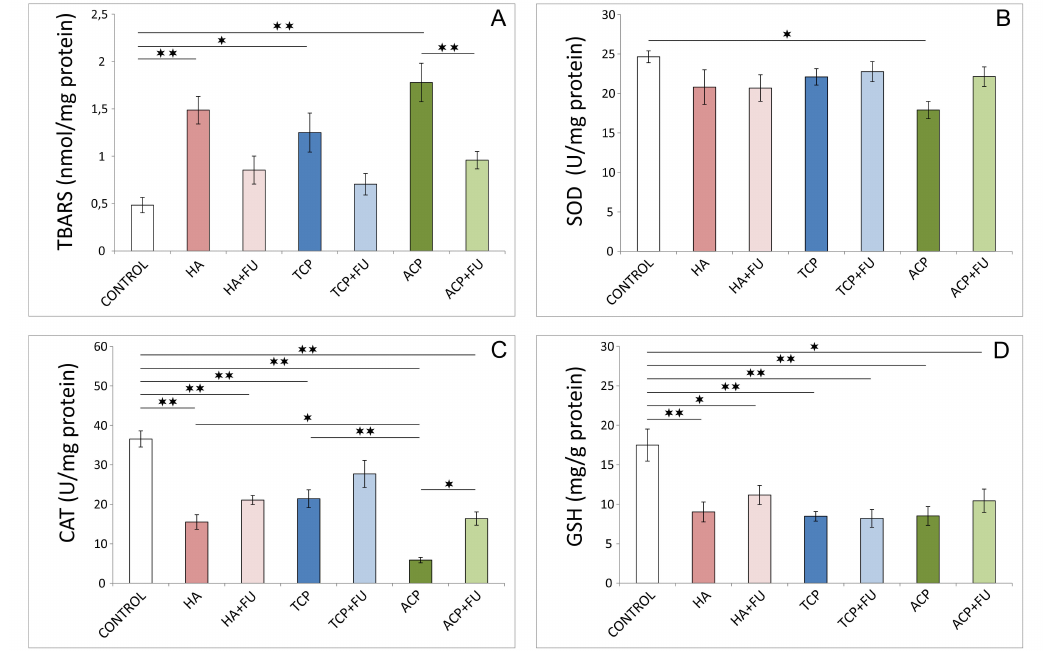
Fig.3. Hippocampaloxidativestressmarkers(6pergroup). (A)Indexoflipidperoxidation(expressedasthiobarbituricacidreactivesubstances–TBARS). (B) CAT (catalase) activity. (C) SOD (superoxide dismutase) activity. (D) GSH (reduced glutathione). HA – hydroxyapatite; HA + FU – hydroxyapatite and Filipendula ulmaria extract; TCP – tricalcium phosphate hydrate; TCP + FU – tricalcium phosphate hydrate and Filipendula ulmaria extract; ACP – amorphous calciumphosphate; ACP+FU–amorphouscalciumphosphateand Filipendulaulmaria extract. Thegraphbarspresentmean ± SEM,*representsasignificant difference p < 0.05, ** represents a significant difference p <